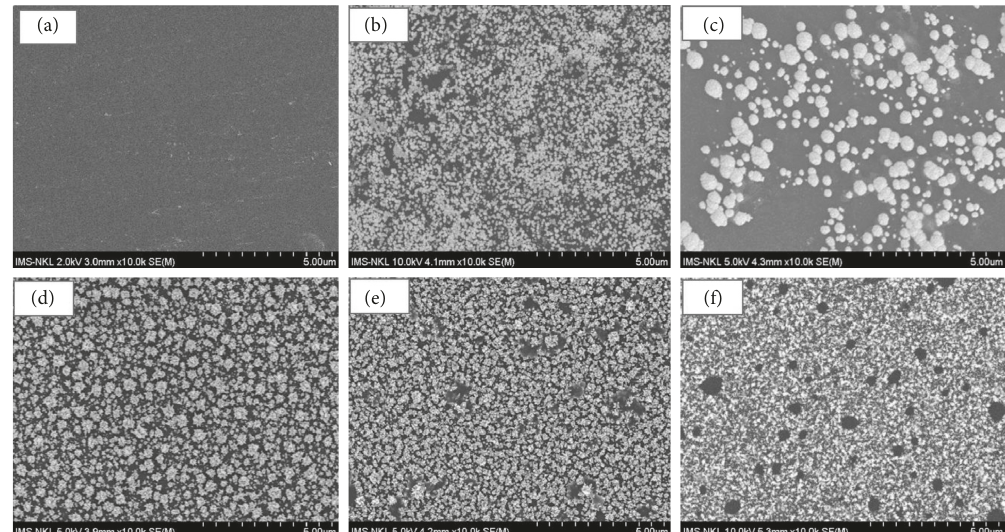
Figure 4: SEM images of GCE (a); PtNFs/GCE deposited at potential of 0.2 V (b), 0.0V (c), − 0.2V (d), − 0.3V (e), and − 0.5V (f). Solution of